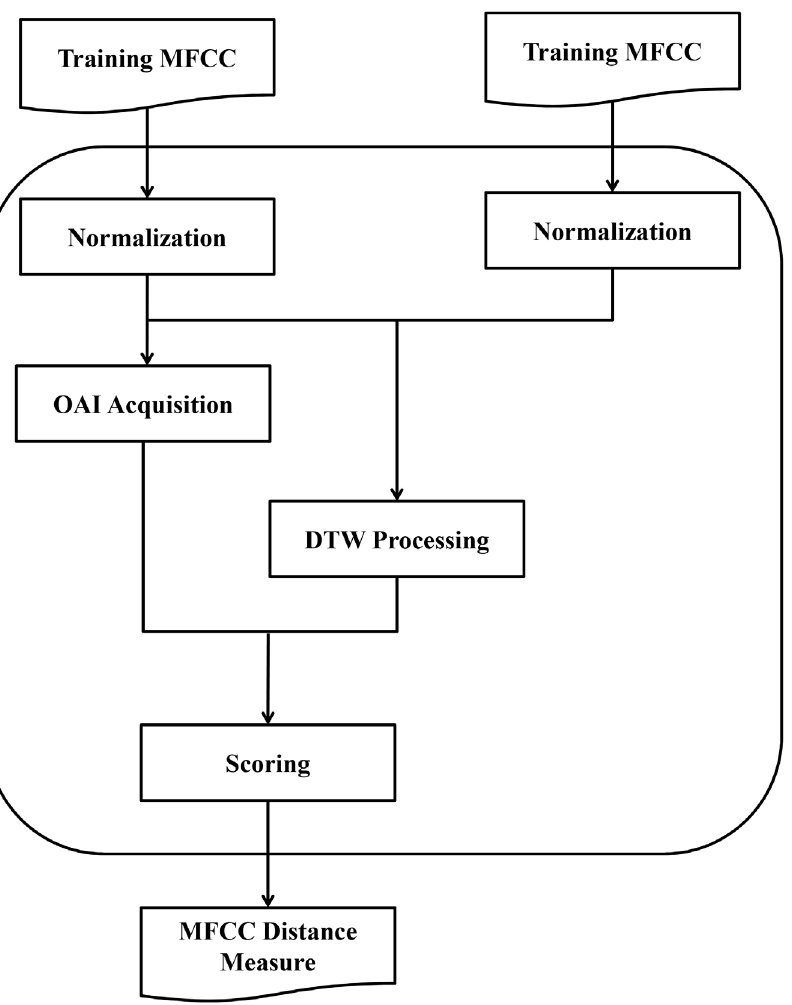
Figure 1. Summary of the proposed one-against-all weighted dynamic time warping (OAWDTW) approach. First, OAWDTW normalizes training MFCCs and testing MFCCs. Then, OAWDTW acquires the one-against-all index (OAI) of each time frame in training MFCCs. Third, OAWDTW performs dynamic time warping alignment between a normalized training MFCC and a normalized testing MFCC. Forth, OAWDTW applies OAIs of aligned time frames in normalized training MFCC to tune the final score.